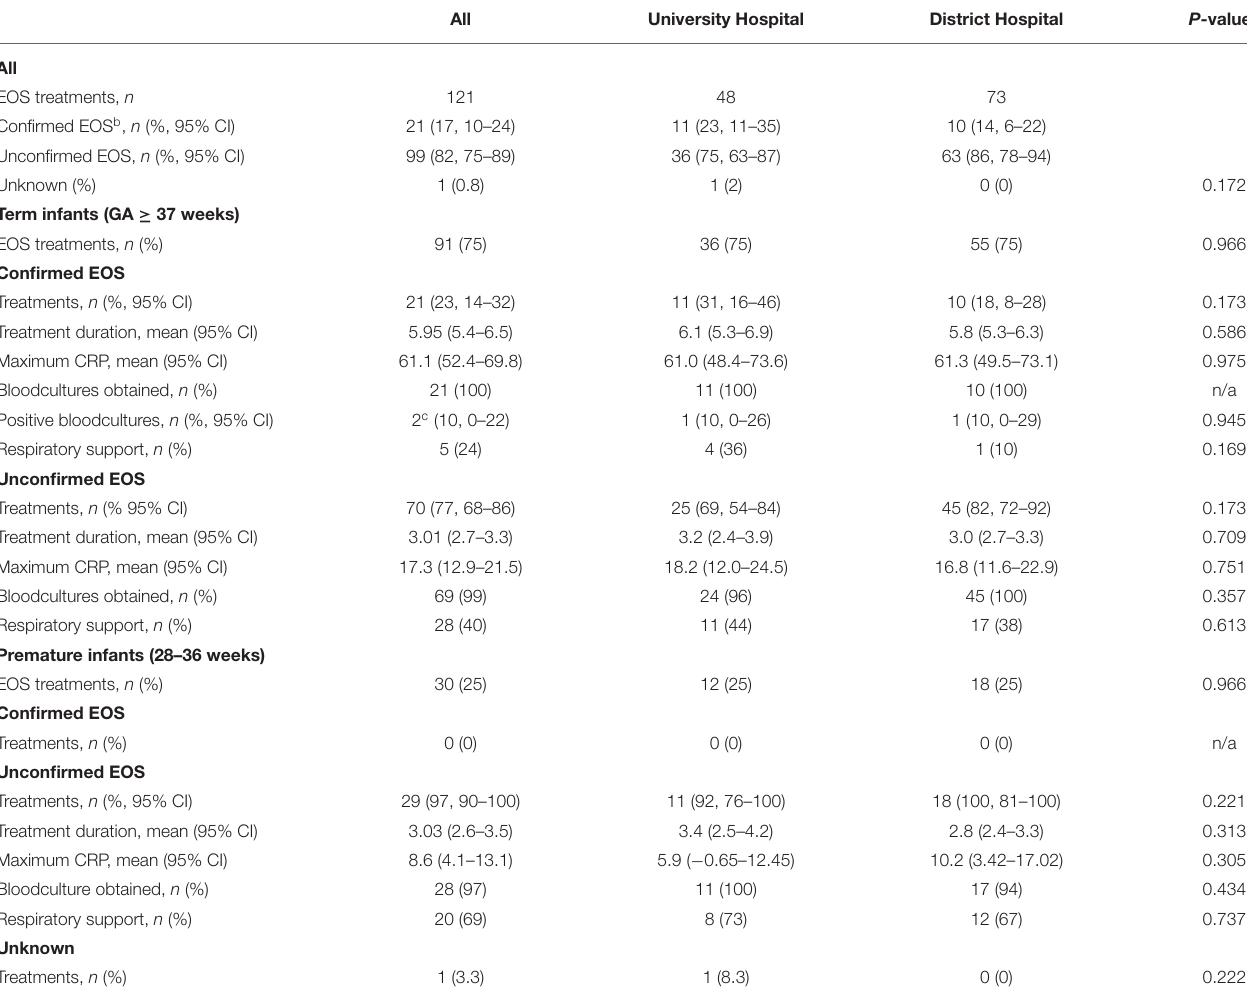
TABLE 3 | Characteristic in treatment of early-onset sepsis (EOS) in two Norwegian neonatal units, gestational age (GA) ≥ 28 weeks. All University Hospital District Hospital P -value